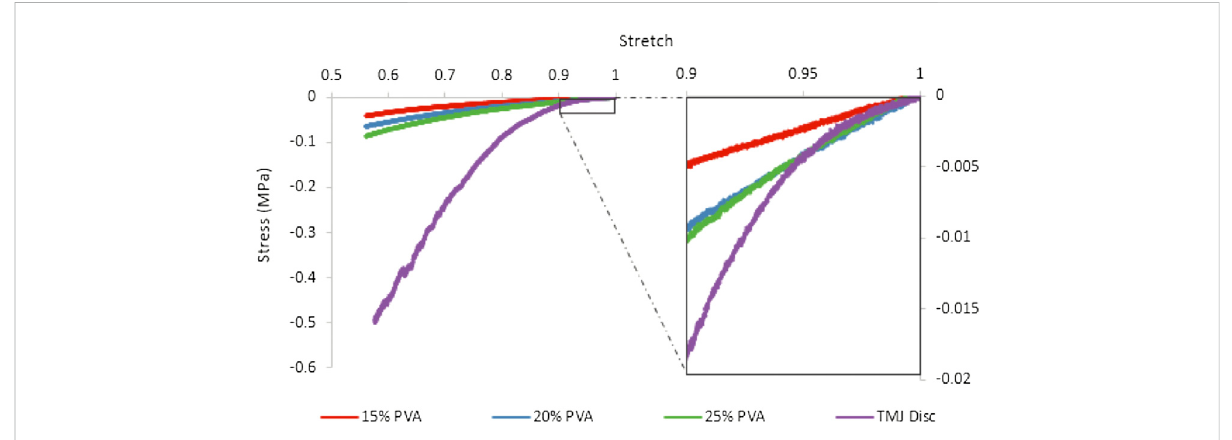
(Figure 7). In the AP direction, the TMJ disc ultimate strength was signi fi cantly greater than all PVA hydrogel materials.